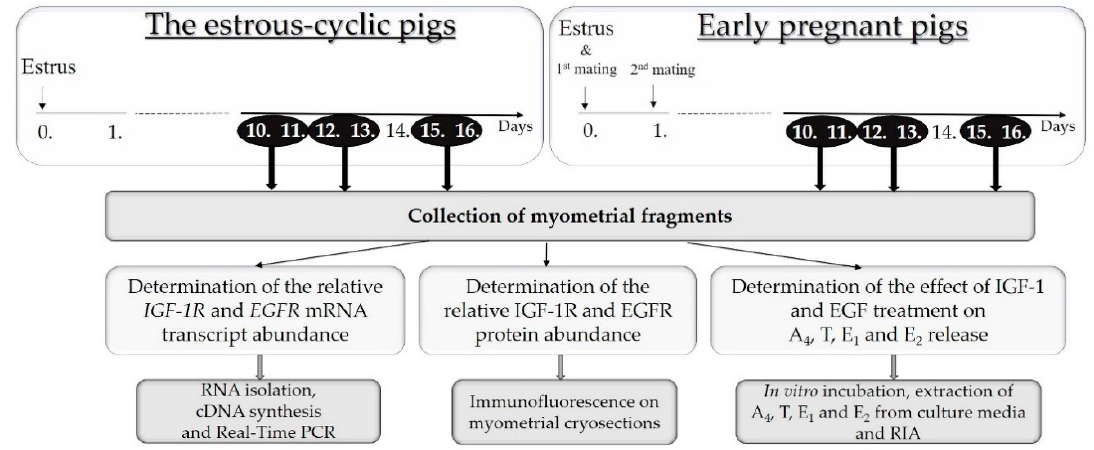
Figure 1. The timeline of the experiment.